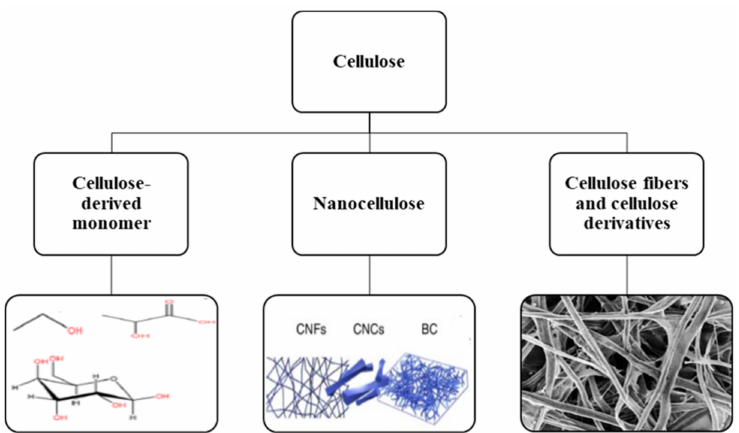
Figure 2. A general classification of different forms of